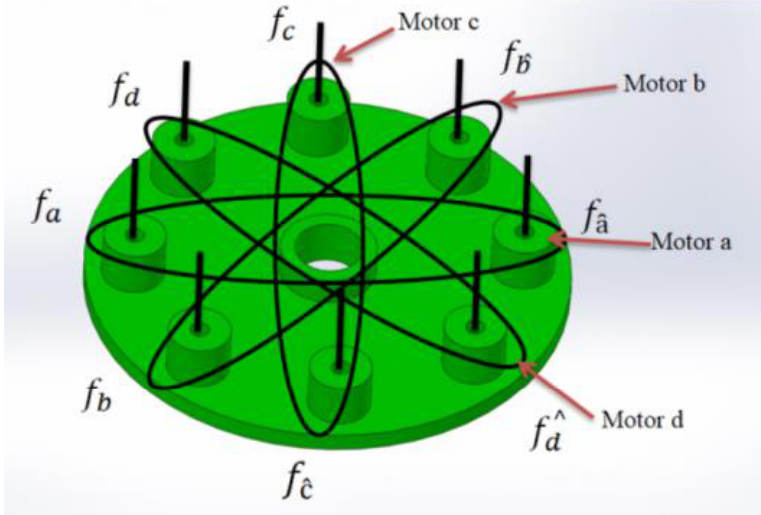
Figure 17. Cable eyelet arrangement for end and mid-section discs.